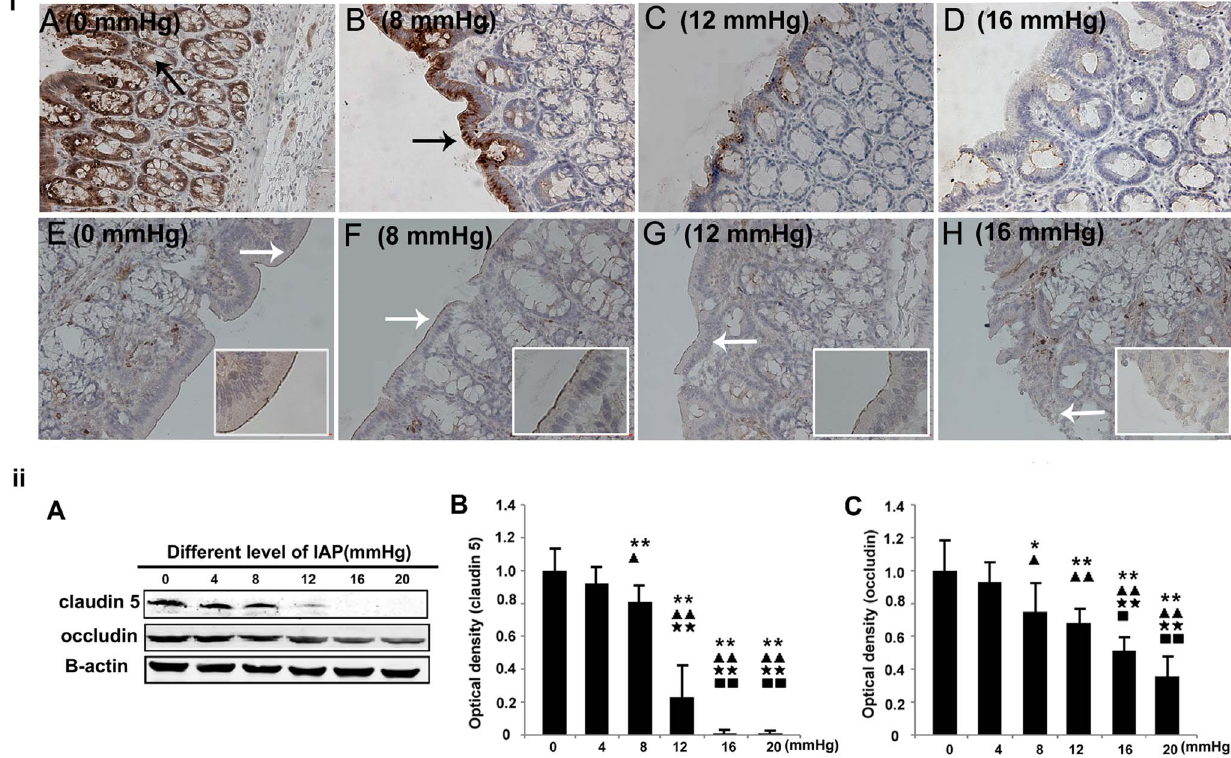
Figure 5. The effects of different grades of nitrogen pneumoperitoneum on the expression levels of TJ proteins. i: Immunohistochemical localization of claudin 5 and occludin ( 6 200). Increased intra-abdominal pressures tended to reduce the expression levels of claudin 5 and occludin. A–D: Claudin 5. The black arrow indicates the positive signals for claudin 5 in the lateral membrane of the epithelia. E–H: Occludin. The white arrows indicate the positive signals for occludin in the apical cell borders of the colonic epithelia. ii: Western blotting results for claudin 5 and occludin. The expression levels of the proteins were normalized relative to actin. Compared with the 0-mmHg group, the 8-, 12-, 16-, and 20-mmHg groups had significantly reduced densities of claudin 5 and occludin. All data are shown as means 6 SD. *P , 0.05, **P , 0.01, vs. 0 mmHg; m P , 0.05, mm P , 0.01, vs. 4 mmHg; ww P , 0.01, vs. 8 mmHg; & P , 0.05, && P , 0.01, vs. 12 mmHg.